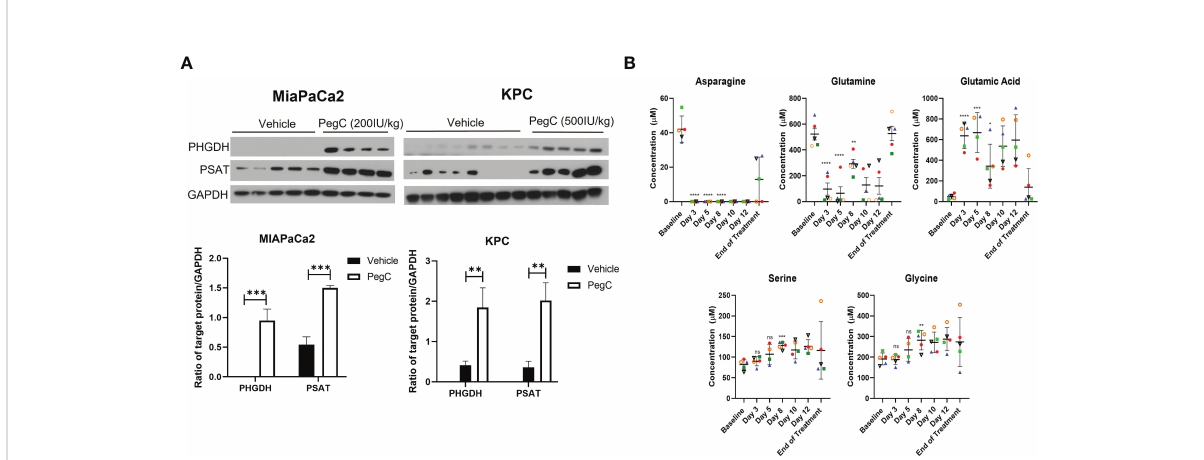
FIGURE 3 PegC upregulates serine biosynthesis enzymes in PDAC tumors (A) Western blot analysis of MIAPaCa2 and KPC tumor lysates from mice either vehicle treated or treated with the indicated dose of PegC (B) Plasma amino acid levels from Erwinaze clinical trial. Changes in plasma amino acid levels following Erwinaze treatment. Each marker represents a different patient (n=5). Statistical analyses were performed using unpaired t- tests. **** p < 0.0001, *** p < 0.001, **p < 0.01, *p <0.05, ns, not signi fi